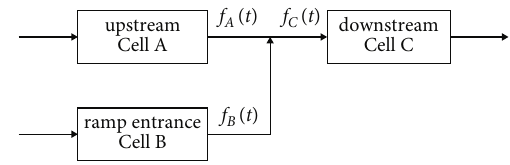
Figure 3: Schematic diagram of the merge road link of